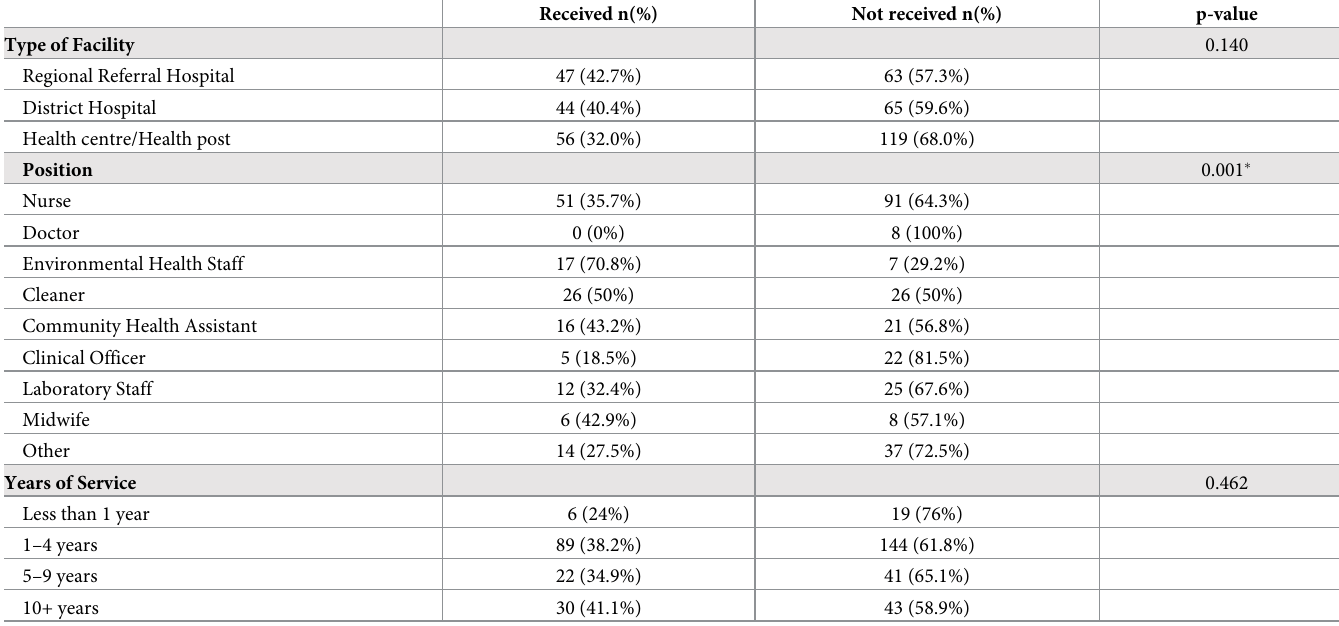
Table 4. Training in health care waste management by job position and years of service.